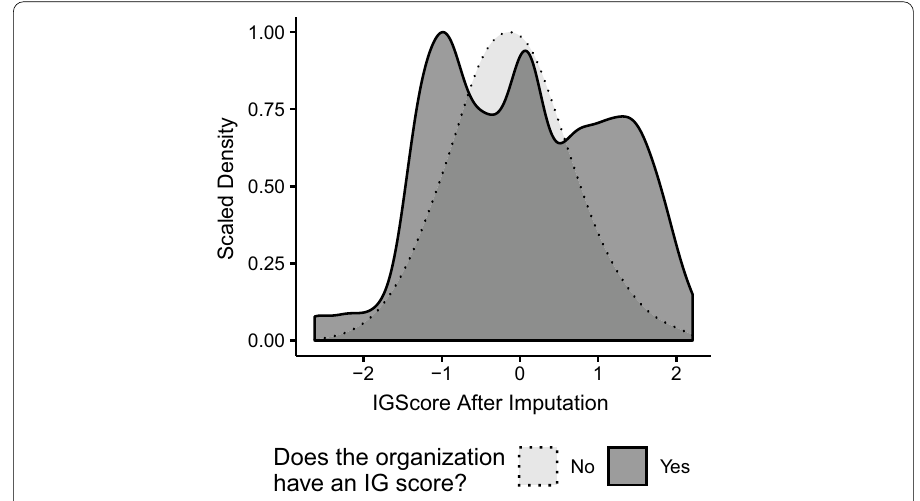
Fig. 2 Real versus imputed IGScores for organizations in the interlock